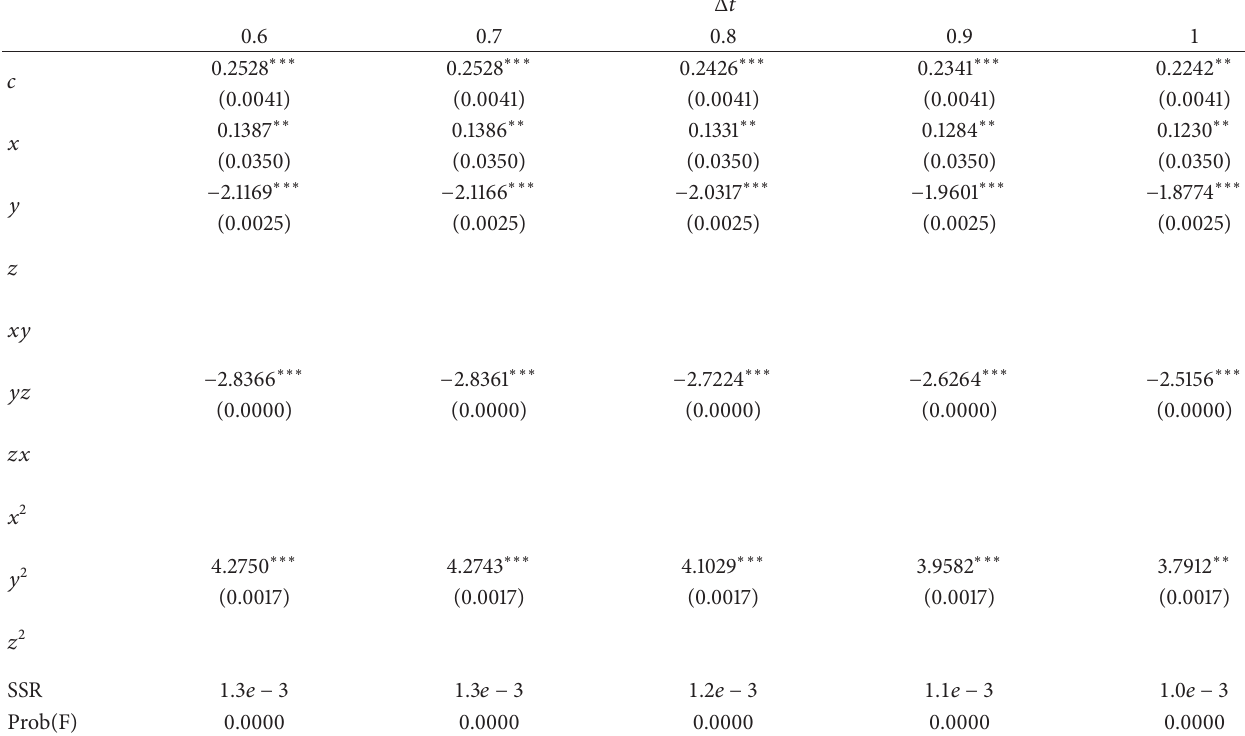
Table 4: The third equation in (9) under the several time steps of discretization.